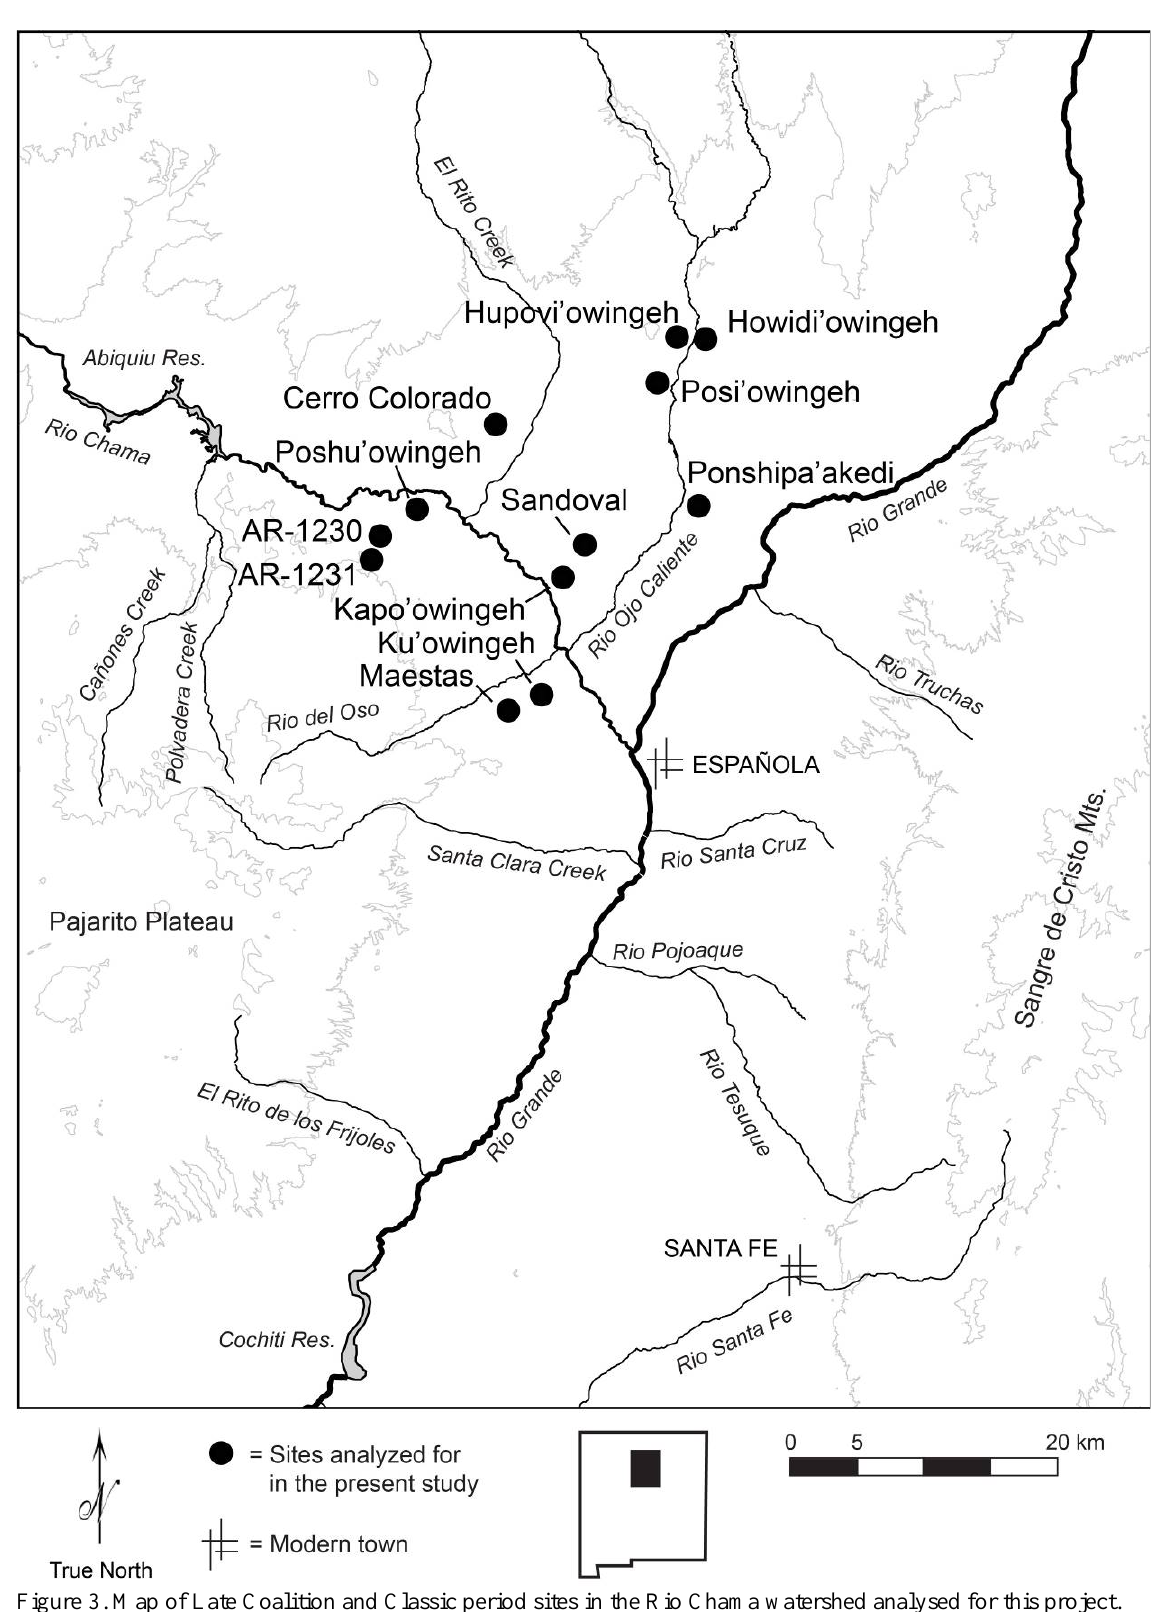
Figure 3. Map of Late Coalition and Classic period sites in the Rio Chama watershed analysed for this